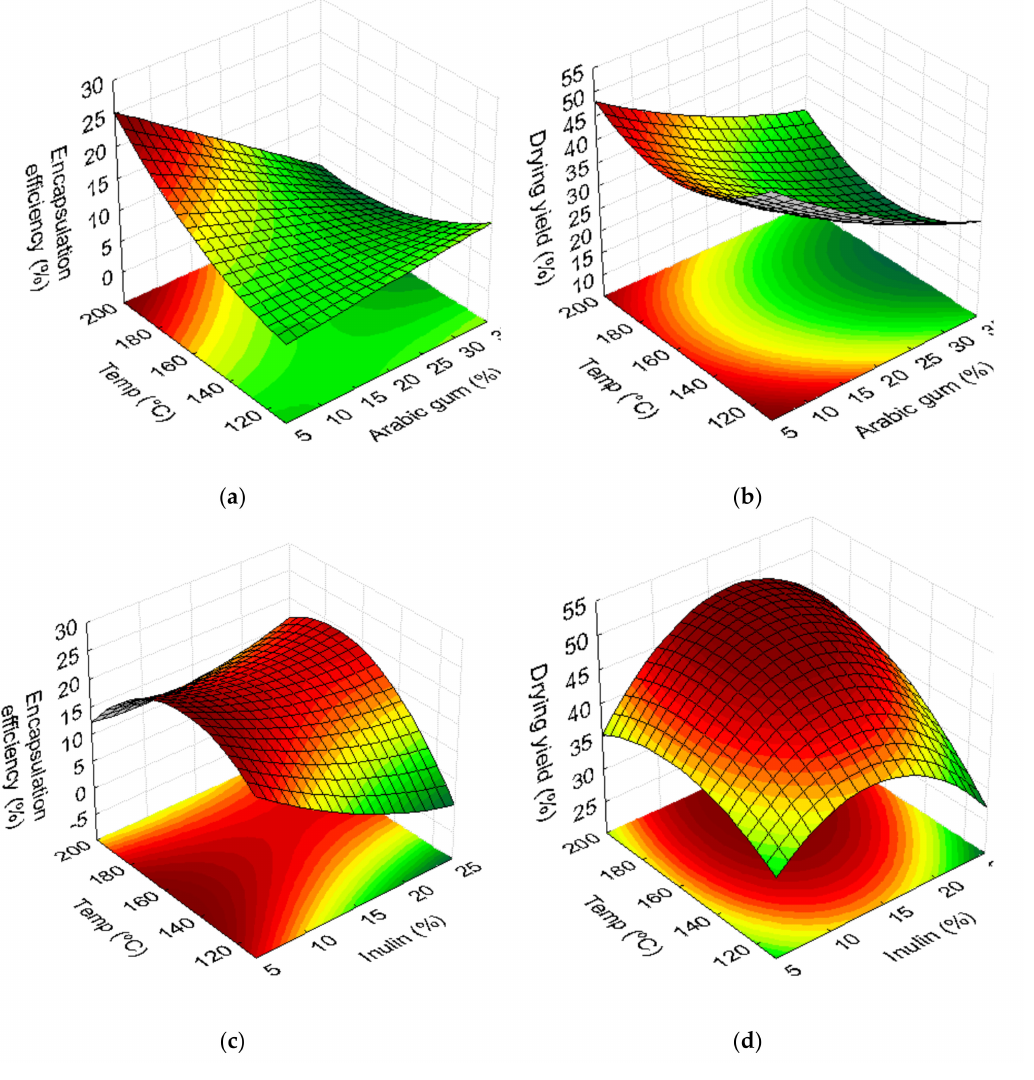
Figure 3. Response surfaces for EE and DY, ( a , b ) arabic gum; ( c , d )